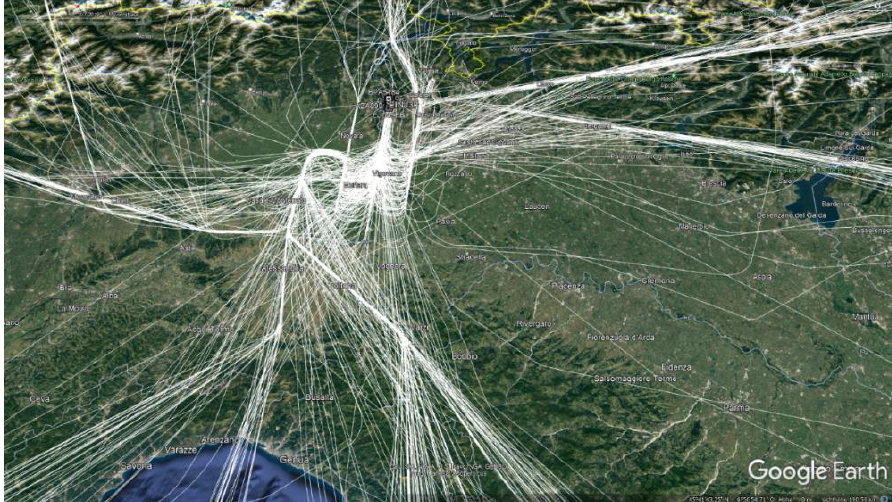
Figure 15. Prepared FlightRadar24 datasets from 6 August 2019 with normal undisturbed weather conditions.